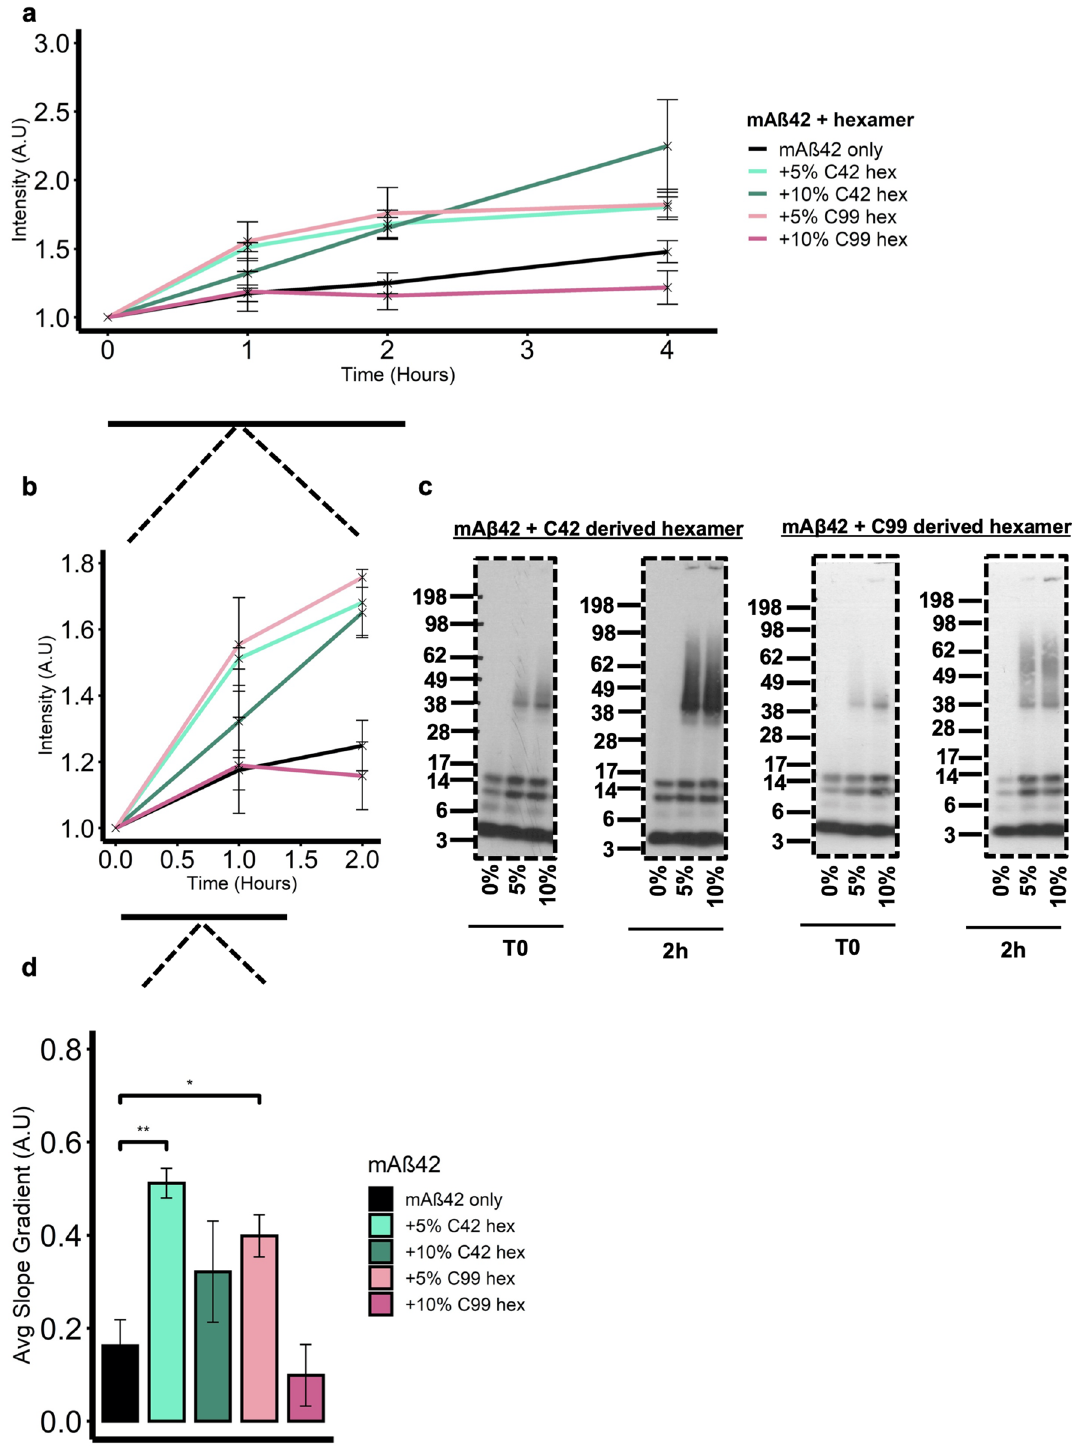
Figure 6. Isolated C42 and C99 derived hexameric Aβ nucleate monomeric Aβ42 (mAβ42). ( a ) 50 µM mAβ42 was seeded with 5- or 10% hexamer and the solution was then incubated with 20 µM ThT. Fluorescence was monitored over 24 h. ( b ) Addition of both 5- and 10% C42 hexamer results in an immediate increase in ThT fluorescence (0–2 h). ( c ) Western blotting with the W0-2 antibody revealed all seeding conditions form higher molecular weight assemblies at T0 and by 2 h what likely correspond to fibrils are seen ‘stuck’ in the wells of the gel. Dashed borders indicate the membrane was cut before detection. ( d ) The gradient of the ThT fluorescence slope was calculated at the early time points of aggregation (0–1 h) and One-way ANOVA with Tukey’s post hoc comparison where p = < 0.01 (*), < 0.001 (**), < 0 (***), revealed addition of 5% C42 hexamer significantly (**) increased the kinetics of aggregation compared to mAβ42 only as did the addition of 5% C99 derived hexamer (*). Error bars are expressed as ±